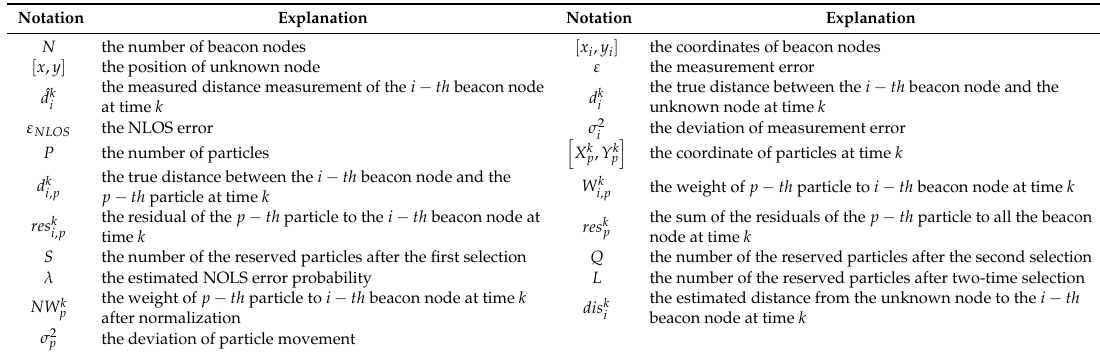
Table 1. List of key